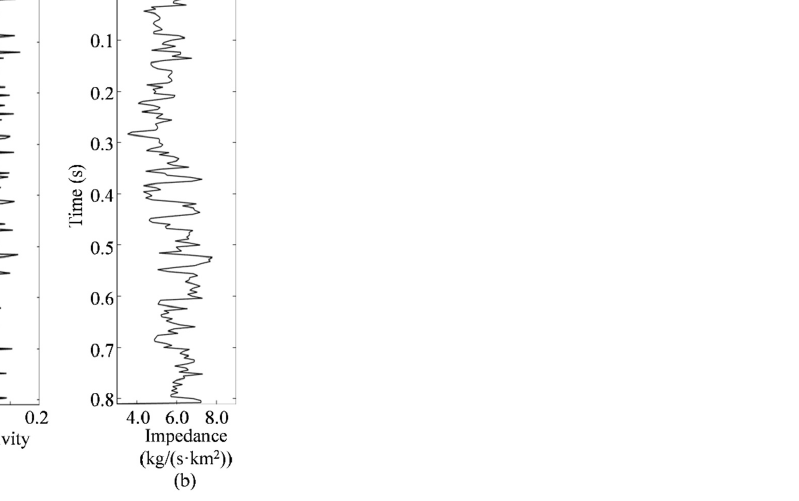
Figure 1. The reflectivity series and the corresponding impedance from an actual well log. ( a ) Reflectivity series; ( b ) impedance.